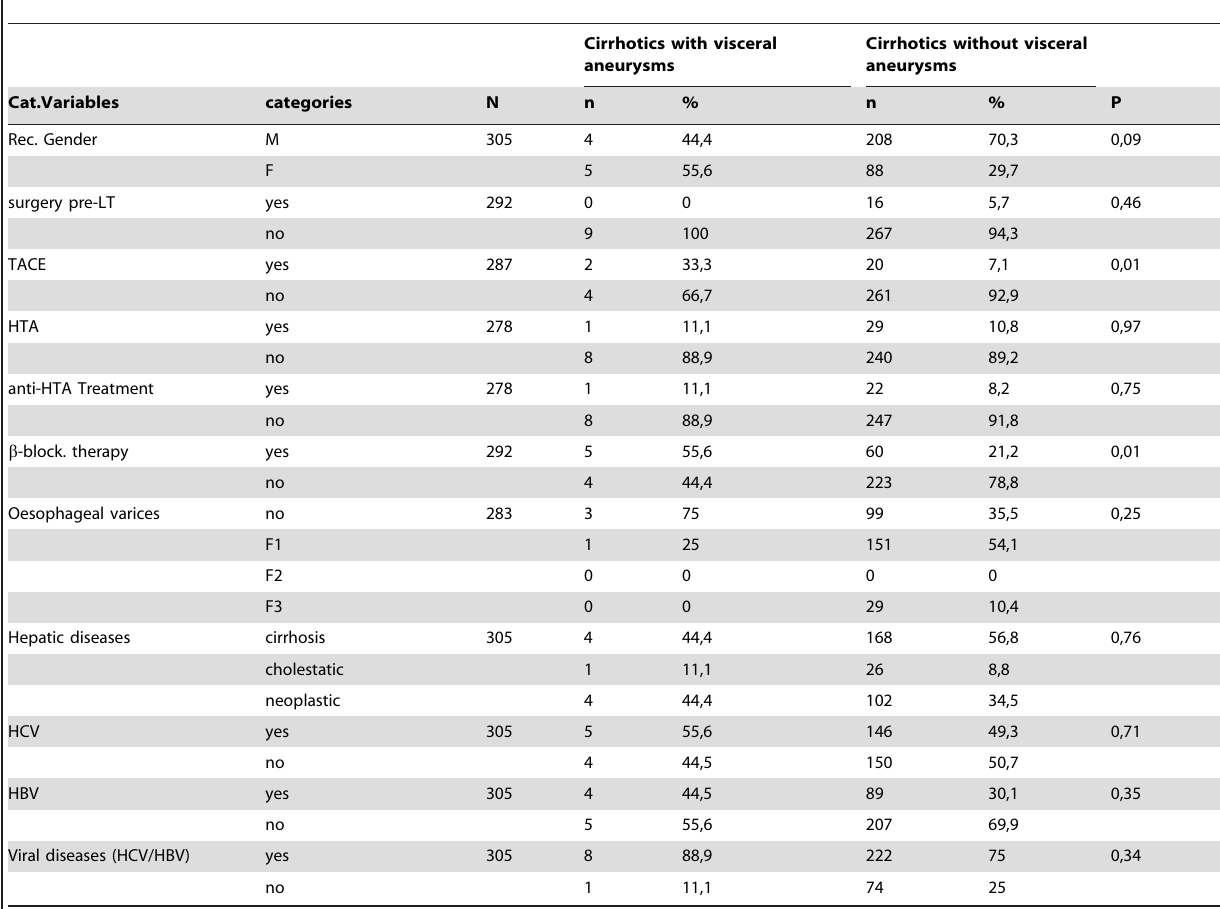
Table 2. Univariate analysis of categorical variables among cirrhotics waiting for LT with and without visceral aneurysms.